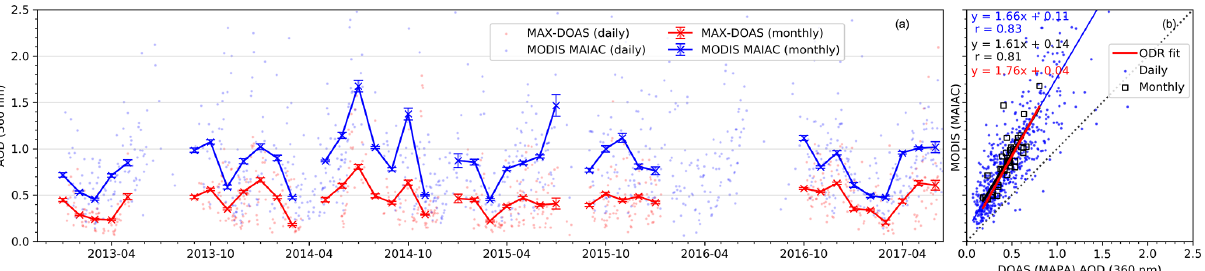
Figure F11. Intercomparison of daily (dots) and monthly mean (lines and markers) AOD at 360nm retrieved from ground-based MAX- DOAS O 4 measurements and from the MODIS MAIAC data product when no scaling factors were applied for the O 4 dSCDs.